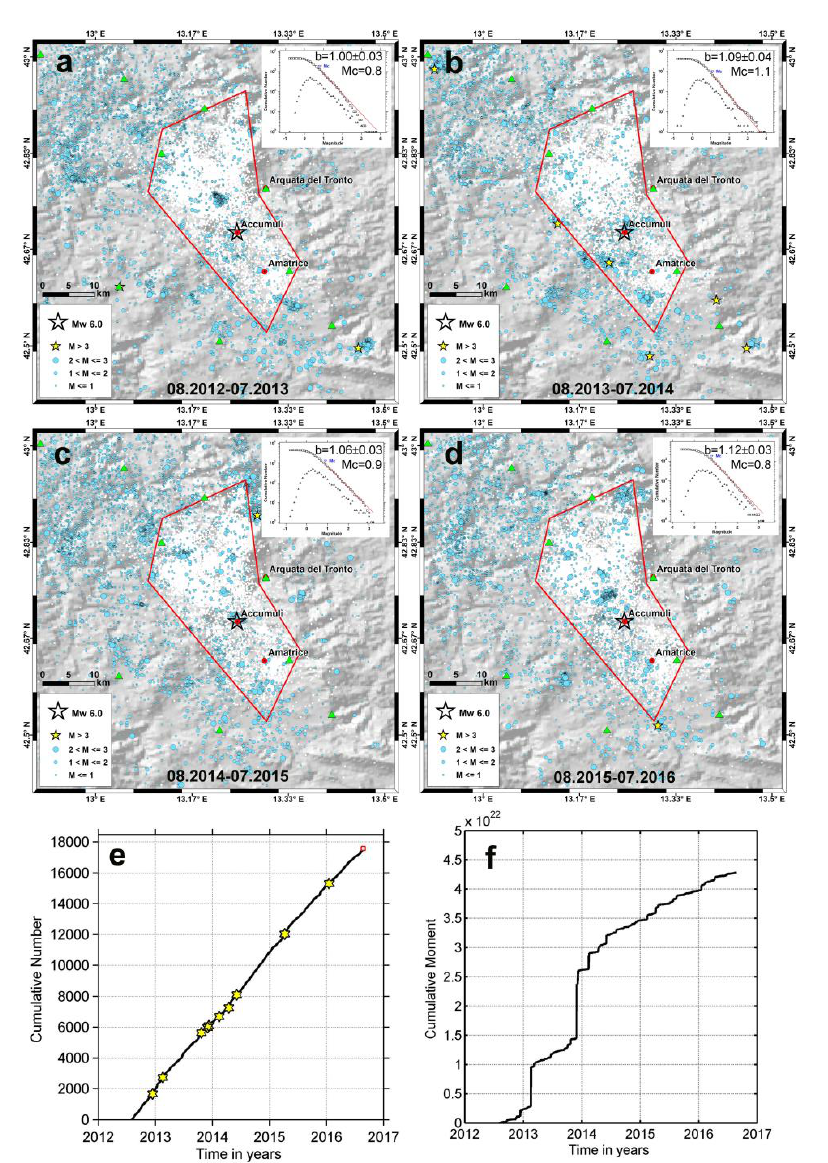
Figure 1. Seismicity around the Amatrice sequence between August 2012 and July 2016. Red polygon: source area. Black star: epicenter of the August 24, 2016 01:36 UTC M W 6.0 earthquake. Green triangles: seismic stations. Blue circles: seismic events before the sequence. White circles: seismic events of the sequence; a): seismicity between August 2012 and July 2013; b): seismicity between August 2013 and July 2014; c): seismicity between August 2014 and July 2015; d): seismicity between August 2015 and July 2016; e): cumulative number of earthquakes in the last four years (yellow stars: events M L ≥ 3.0); f): cumulative seismic moment released in the last four